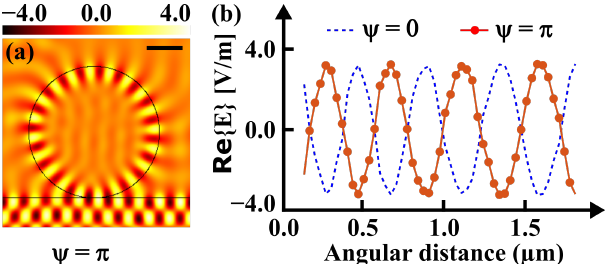
Figure 1. Collection of an evanescent wave by a glass microsphere (see Visualization 1 in Supple- mentary Materials). ( a ) Real part of the electric field distributions when the initial phase ψ of the excitation wave is of π . Black-scale bars represent 1 µm. ( b ) Radial section profiles at a radius of 1.4 µm of ( a ) as a function of the angular position when ψ equals 0 rad and π rad. λ 0 = 600 nm, θ = 1 rad, n s = 1.5, D = 3 µm.